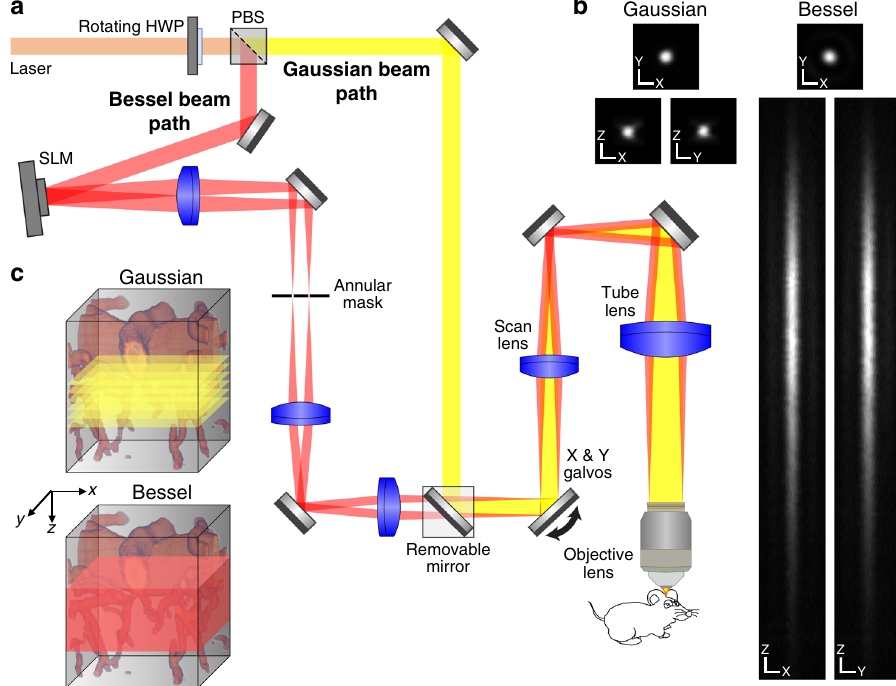
Fig. 1 Design and characterization of a commercial two-photon laser scanning microscope with a Bessel focus module. a Schematic of the microscope. A half-wave plate (HWP), a polarizing beamsplitter (PBS), and a removable mirror allow switching between Bessel (red) and Gaussian (yellow) beam paths. In the Bessel path, a spatial light modulator (SLM) and a lens generate an annular illumination pattern, which after spatial fi ltering by an annular mask is imaged via a 4f system onto the galvos and subsequently imaged via a scan and tube lens pair onto the objective lens back focal plane. b Lateral and axial point spread functions for Gaussian and Bessel foci. X and Y scale bars: 1 µ m. Z scale bar: 5 µ m. Results from one 0.2- µ m-diameter bead. c Schematic comparison of Gaussian and Bessel volumetric TPLSM methods. Gaussian volumetric imaging requires multiple 2D frames taken at different Z-positions, while Bessel volumetric imaging is achieved with a single